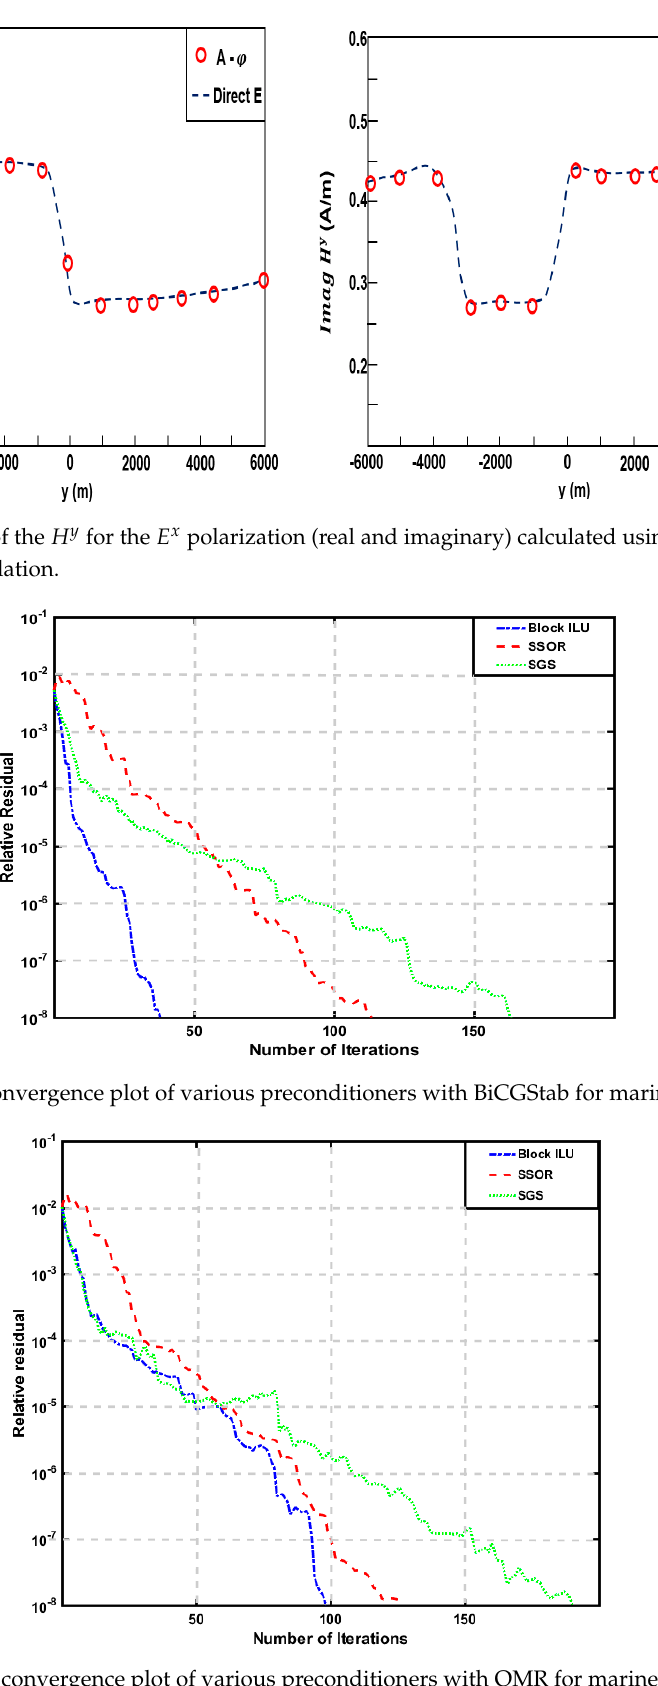
Figure 9. The planar and vertical cross-section view of the model 3. The anomalous bodies are embedded in the middle homogenous layer. The computed grid domain is discretized into 60 × 53 × 28 cells in the x, y, and z-directions. Both horizontal direction is 115 km while the vertical extent is 185 km. A plane wave source at frequency of 0.001 Hz was used for the model. Figures 10 indicate the plot of the real and imaginary part of the normalized electric field for the 𝐸 (cid:3051) polarization from our potential algorithm and direct E approach. The results are in good agreement with each other. Both imaginary and real parts of the 𝐸 (cid:3051) reflect the horizontal changes in the model structure with sharp changes at the resistivity discontinuities. The real and imaginary part of the magnetic field for the 𝐸 (cid:3052) polarization from our potential algorithm and direct 𝐸 formulation are shown in Figure 11, again indicating that their results are consistent.